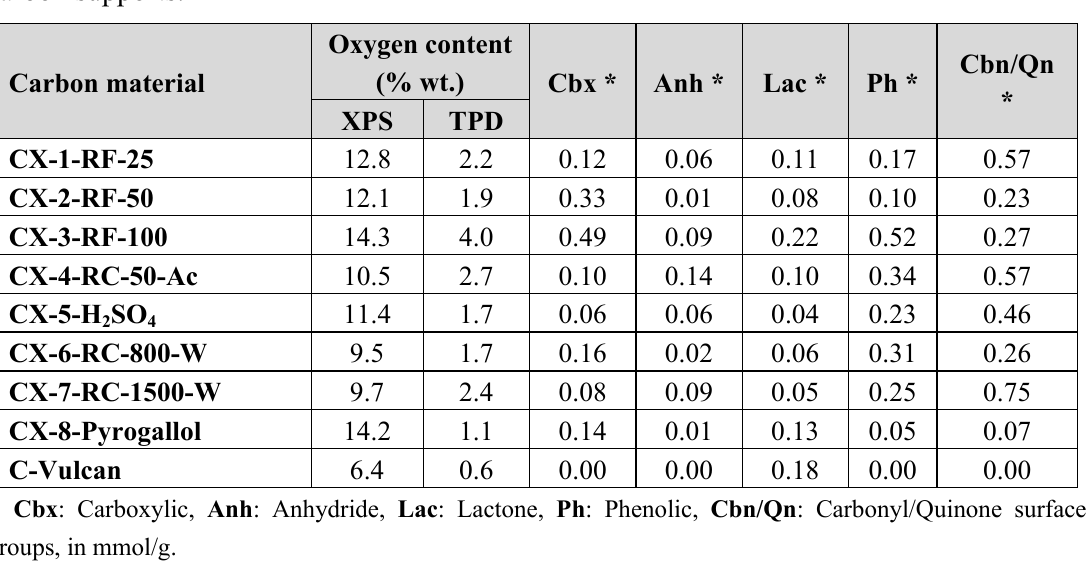
TPD profiles for the 2